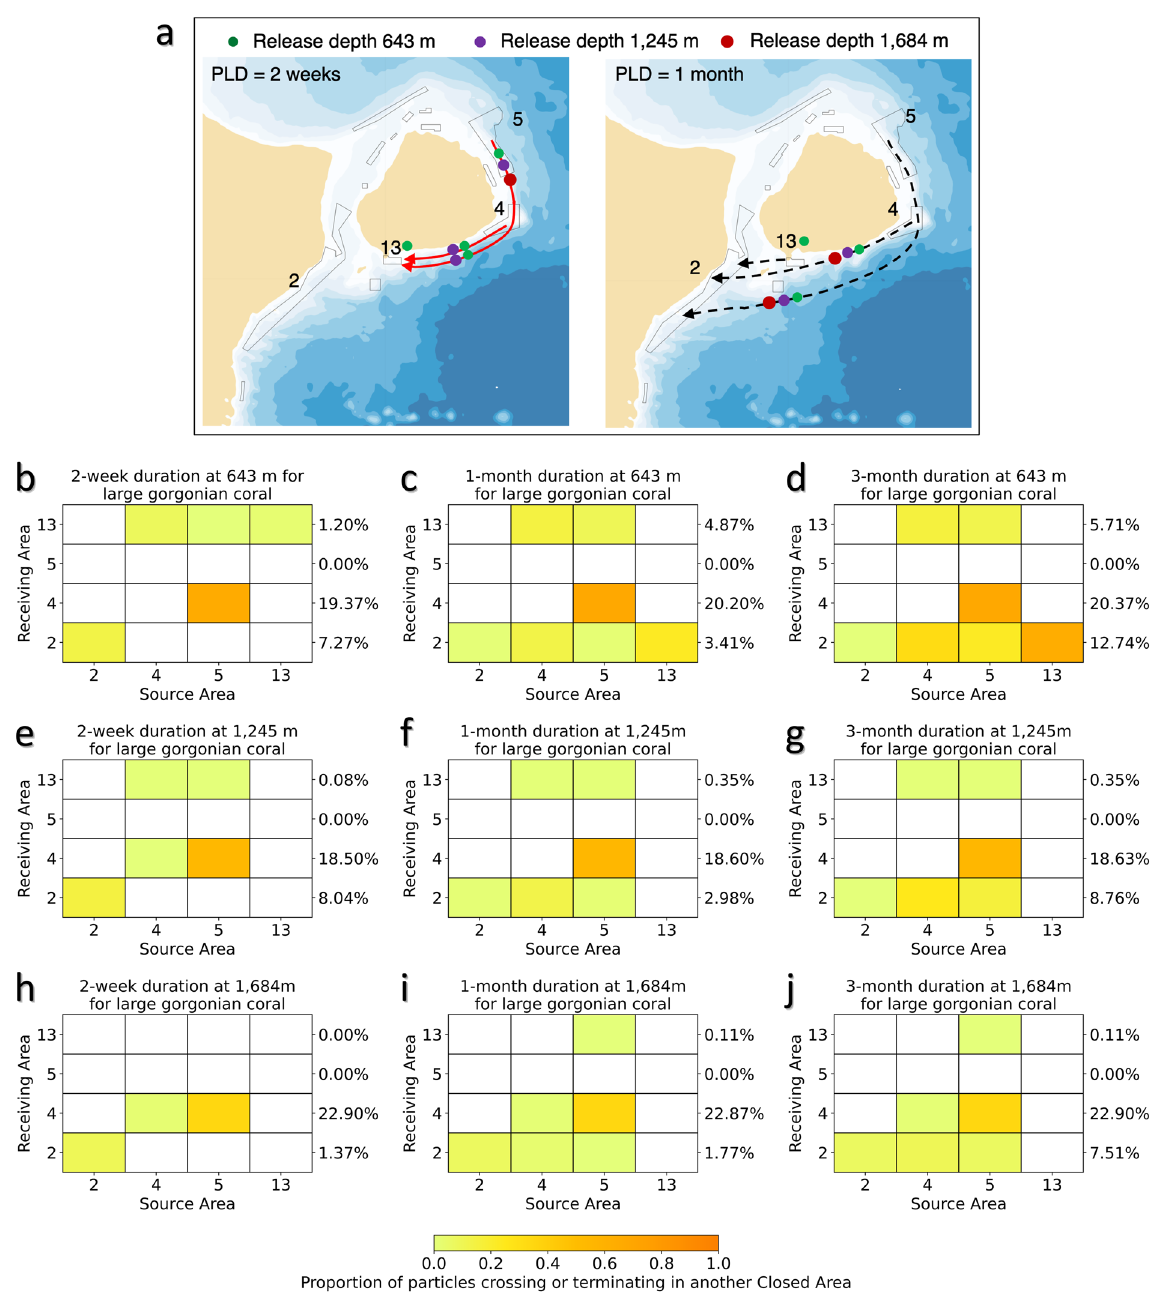
Figure 7. Functional connectivity among areas closed to protect large Gorgonian corals. ( a ) Forward-tracking connectivity pathways for particles released at 3 depths in each of the 4 areas closed to protect large gorgonian corals (Areas 2, 4, 5, 13). Drift durations shown are 2 weeks and 1 month. The connectivity map with 3-month drift duration is not shown because it is the same as that of 1-month drift duration. The closed circles near the number code of some of the closed areas denotes that particles from this area are only released at this depth due to the limitation of maximum depth, and the closed circles over the lines indicates particles can reach another closed area when released from this depth. The maps were generated using bathymetry and coastline data produced and made publically available by the NOAA National Centers for Environmental Information (NCEI). The ETOPO1 Ice Surface (https:// doi. org/ 10. 7289/ V5C82 76M) arc-minute global relief model of the Earth’s surface (https:// www. ngdc. noaa. gov/ mgg/ global/) was used to generate bathymetry and the Global Self-consistent, Hierarchical, High-resolution Geography Database (GSHHG; https:// www. ngdc. noaa. gov/ mgg/ shore lines/ gshhs. html) was used to produce co-ordinates for a high-resolution coastline and both plotted using Matlab version 9.5 software (https:// www. mathw orks. com) with the M_Map mapping package (version 1.4 m, created by R. Pawlowicz, https:// www. eoas. ubc. ca/ ~rich/ map. html); ( b – j ) The proportion of modeled particles released from each of the 4 areas closed to protect large gorgonian corals (Source Areas; Areas 2, 4, 5, 13) and passing over or terminating in another area closed to protect large gorgonian corals (Receiving Areas). For each Receiving Area the percentage of the total number of particles released (from all Source Areas) are provided. Those values include particles that crossed, terminated or were retained in the Receiving Area. Particle release depths were 643 m ( b – d ), 1245 m ( e – g ) and 1684 m ( h – j ) with drift durations of 2 weeks ( b , e , h ), 1 month ( c , f , i ), and 3 months ( d , g , j